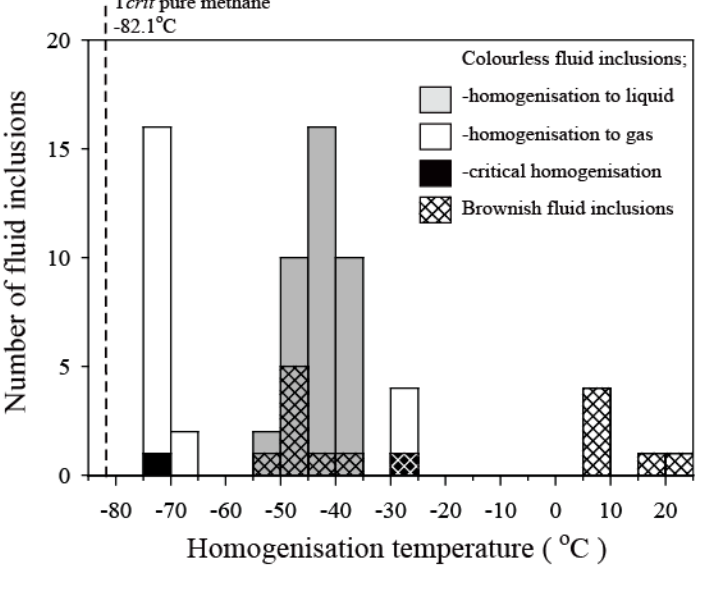
Figure 13. Frequency histogram of homogenisation temperature for hydrocarbon fluid inclusions. T crit = critical temperature, indicated by a dashed line. The cross-pattern marks data for brown-coloured